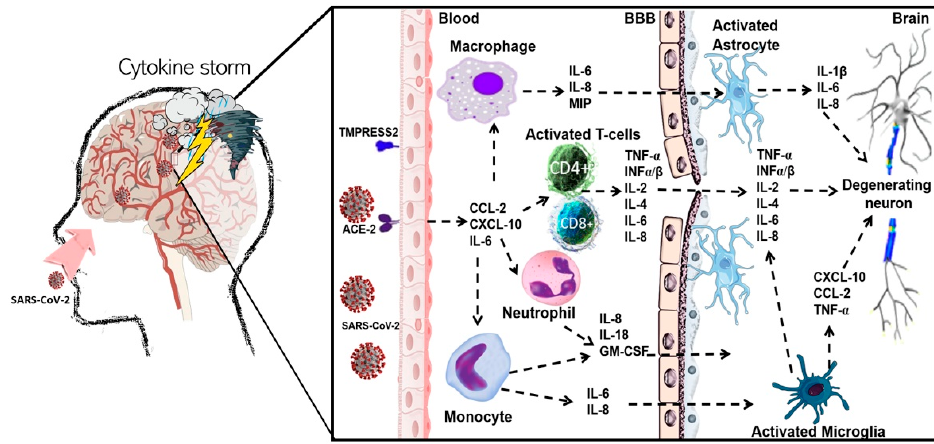
Figure 2. Potential mechanism of severe acute respiratory syndrome coronavirus 2 (SARS-CoV-2)-induced demyelination in human. Coronavirus disease 2019 (COVID-19) is mainly initiated by SARS-CoV-2 through olfactory transmucosal invasion as an entrance into the CNS. The SARS-CoV-2 virus may influence various immune cells, such as macrophages and T cells, as well as being able to interact with endothelial cells via specific receptors ACE2 and TMPRESS2, which work as a gateway for the virus. Such action may be indirectly engaged in BBB damage and demyelination during MS development. SARS-CoV-2 is responsible for recruitment of the massive number of immune cells (especially CD4+ and CD8+ T cells and macrophages) into the CNS, which induce demyelination in MS. Infection of immune cells by SARS-CoV-2 causes severe upregulation of proinflammatory cytokines and chemokines (so called “cytokine storm”), such as IL-1 β , IL-2, IL-4, IL-6, IL-8, TNF- α , INF- α / β , MIP1, GM-CSF, CCL5, and CXCL10. Furthermore, macrophages infected by SARS-CoV-2 show increased levels of IFN- α / β as well as other pro-inflammatory cytokines but with a substantial time delay. Abbreviations: angiotensin-converting enzyme 2 (ACE2); blood-brain barrier (BBB); CC chemokine ligands (CCL); central nervous system (CNS); chemokine (C-X-C motif) ligand (CXCL); coronavirus disease 2019 (COVID-19); granulocyte-macrophage-colony-stimulating factor (GM-CSF); interferon (INF); interleukin (IL); macrophage inflammatory protein 1 (MIP1); multiple sclerosis (MS); severe acute respiratory syndrome coronavirus 2 (SARS-CoV-2); transmembrane serine protease 2 (TMPRSS2), tumor necrosis factor α (TNF- α ).